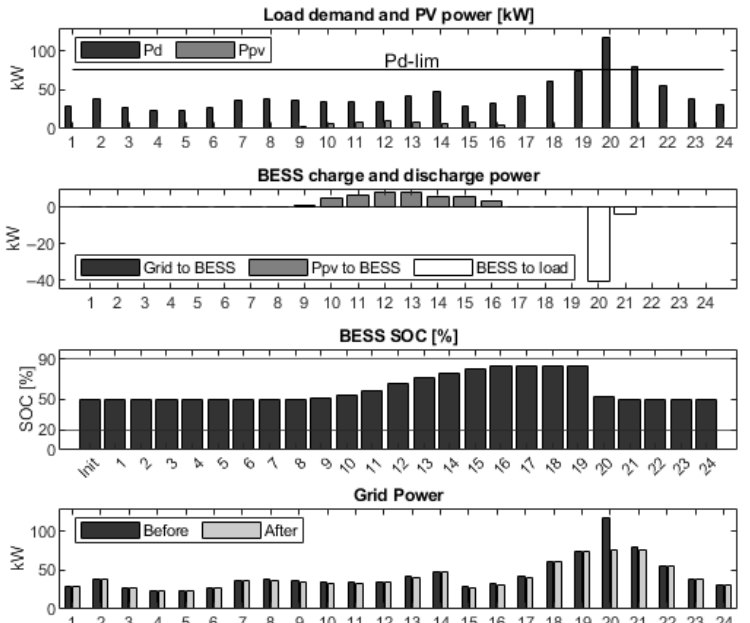
Figure 9. Load demand and PV profile, charge and discharge behavior of the BESS as well as SOC during a day, and a power profile comparison before and after peak shaving operation (the 13th of April).